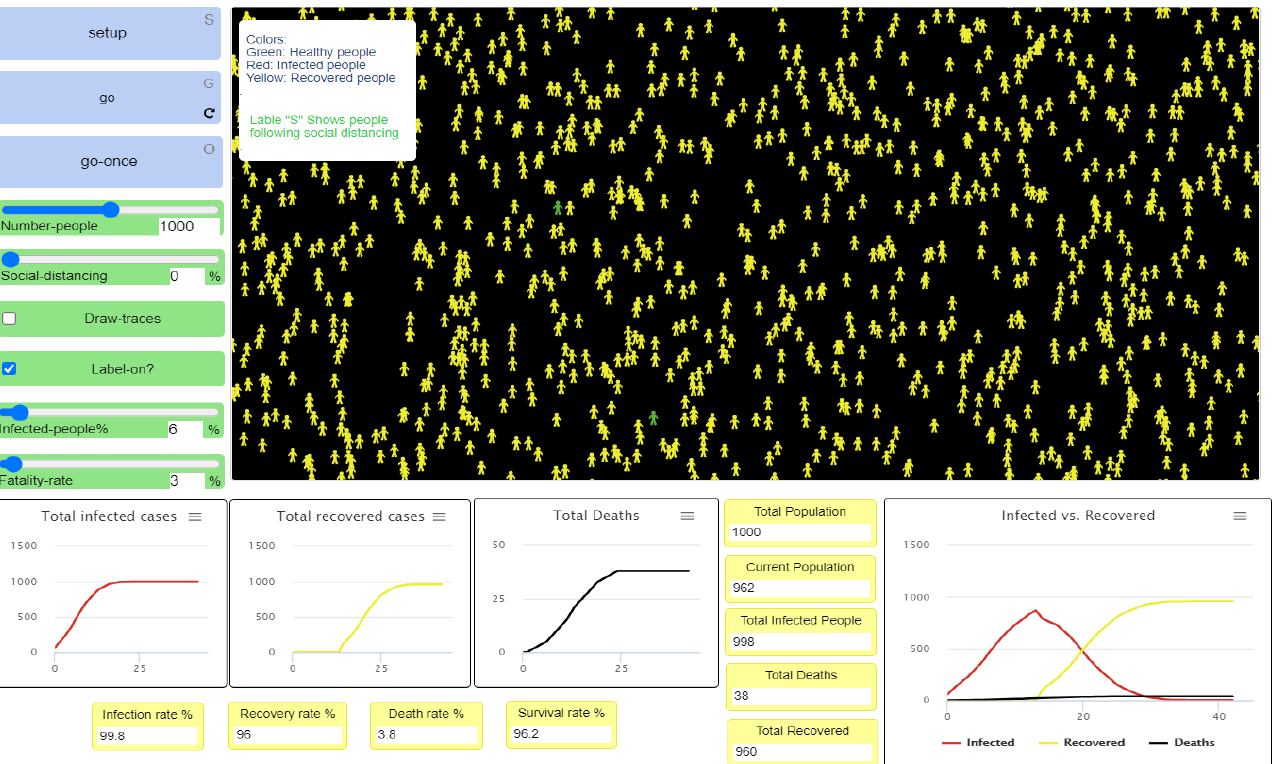
Figure 7. First experiment results of 0% social distancing.